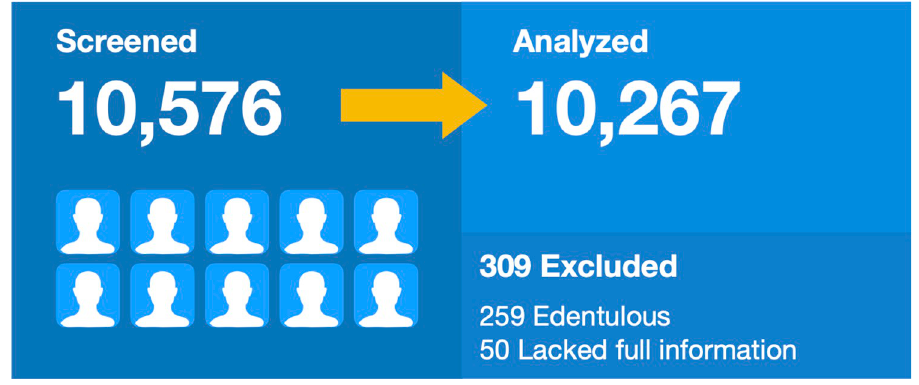
Fig 1. Flowchart of patients in the present study.